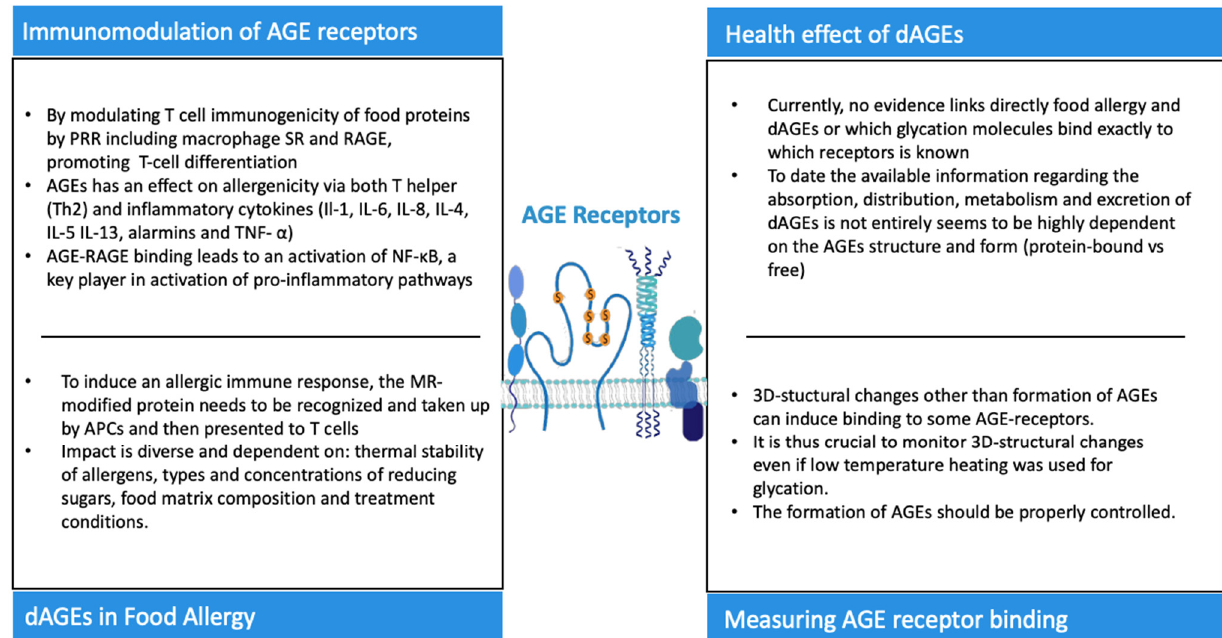
Figure 5. Key messages regarding AGE receptors and their role in the innate and adaptative immune system plus the health effects of dAGEs.